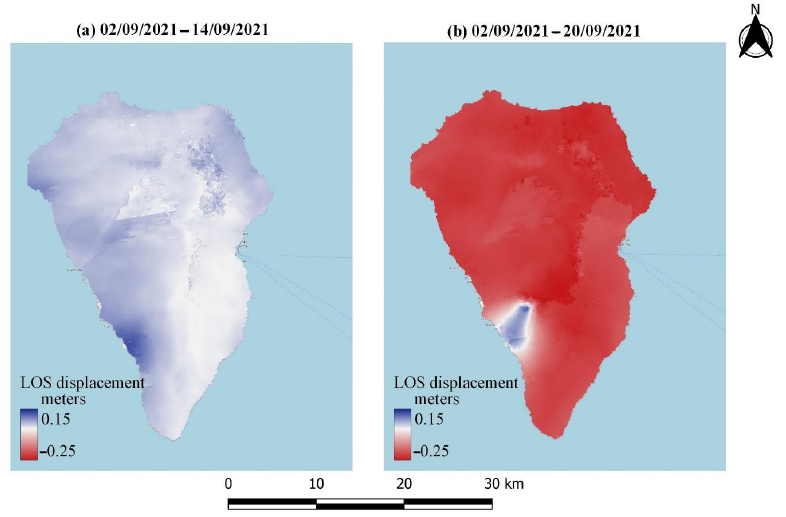
Figure 6. LOS displacement obtained by processing the Sentinel-1 ascending imagery. ( a ) LOS displacement before the eruption. ( b ) LOS displacement after the eruption.